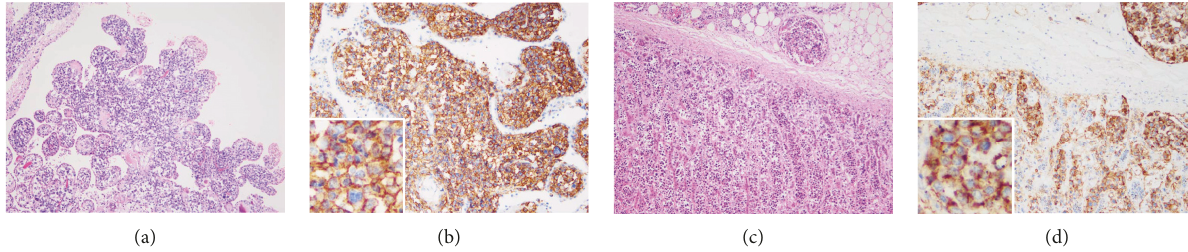
Figure 4: Autopsy findings. (a, b) Choroid plexus. (a) Hematoxylin and eosin staining. Magnification, × 100. (b) CD20 staining. Mag- nification, × 200. (c, d) Adrenal gland. (c) Hematoxylin and eosin staining. Magnification, × 100. (d) CD20 staining. Magnification, ×